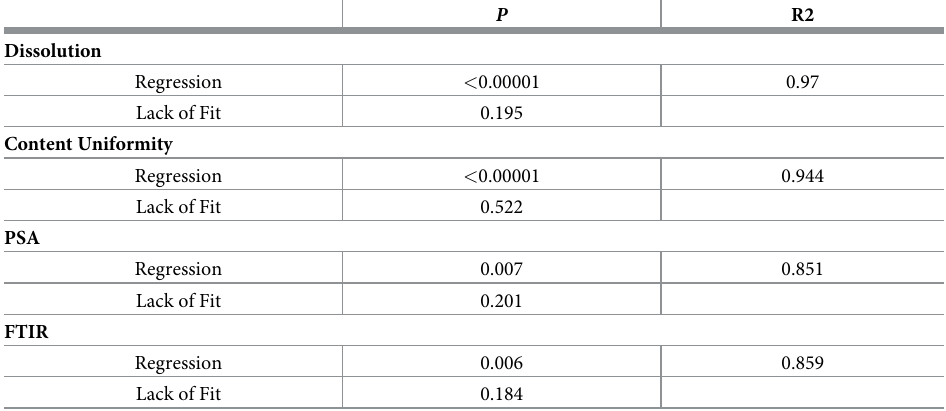
Table 6. Summary of results obtained from ANOVA of the four responses to test model validity. P is probability and R2 is the regression coefficient. P